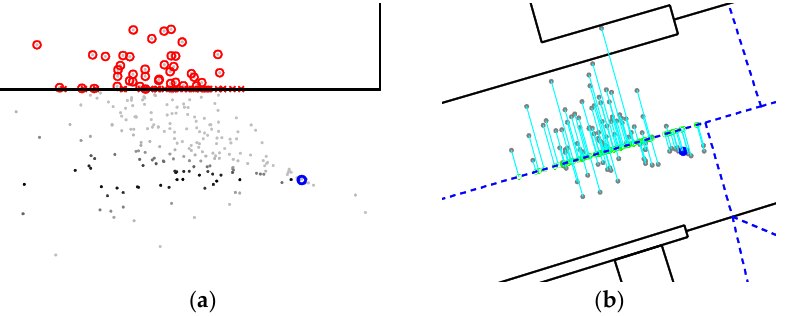
Figure 4. Principles of support: ( a ) floor plan—red particles are behind wall and are weighted zero; and ( b ) routing graph—the orthogonal offset of a particle to the nearest routing edge is used to calculate its weight [21].